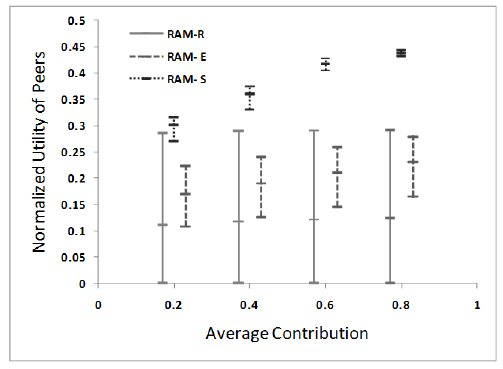
Fig. 5. Distribution of the normalized utility of individual peers.